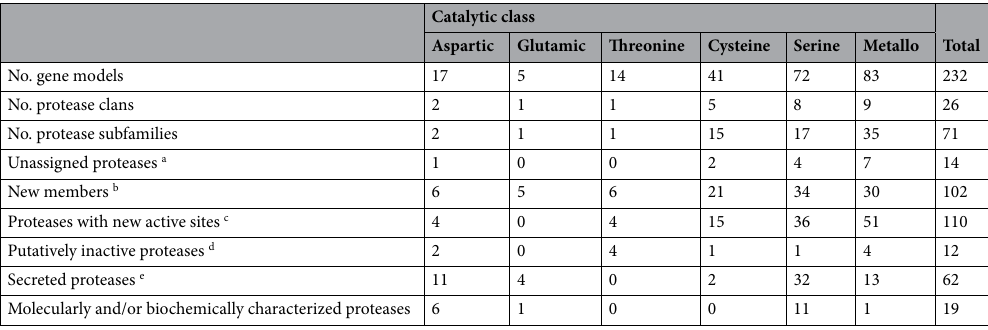
Table 1. Summary of the main characteristics of the putative proteases annotated from the A. niger genome. a Number of peptidases that can not be assigned into any clan or family based on current classification system. b New members are proteases newly assigned into the class or proteases whose catalytic classes are different from those identified in the literature. For more details, see protease classes colored in red in Supplementary Table S2. c Proteases with new active sites represent proteases that have different active sites and/or metal binding residues from those deposited in version 12.2 MEROPS database. For more details, see the active sites and/or metal binding residues colored in red in Supplementary Table S2. d Based on the absence of consensus active site residues in the amino acid sequences of the proteases. e Based on the analyses of the six subcellular location